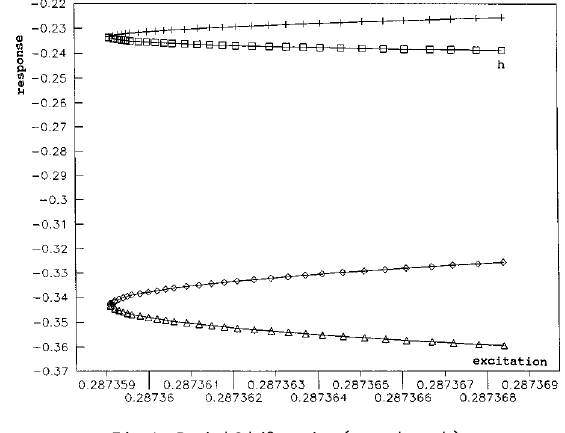
Fig. 4a. Period 8 bifurcation (upper branch).